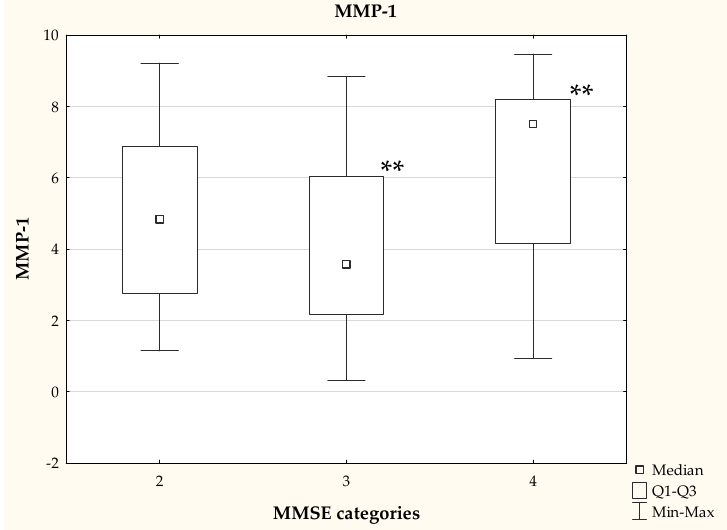
Figure 2. MMP-1 concentration depending on the MMSE category—data presented as medians, statistically significant differences between groups (Kruskal Wallis test), ** p < 0.01.